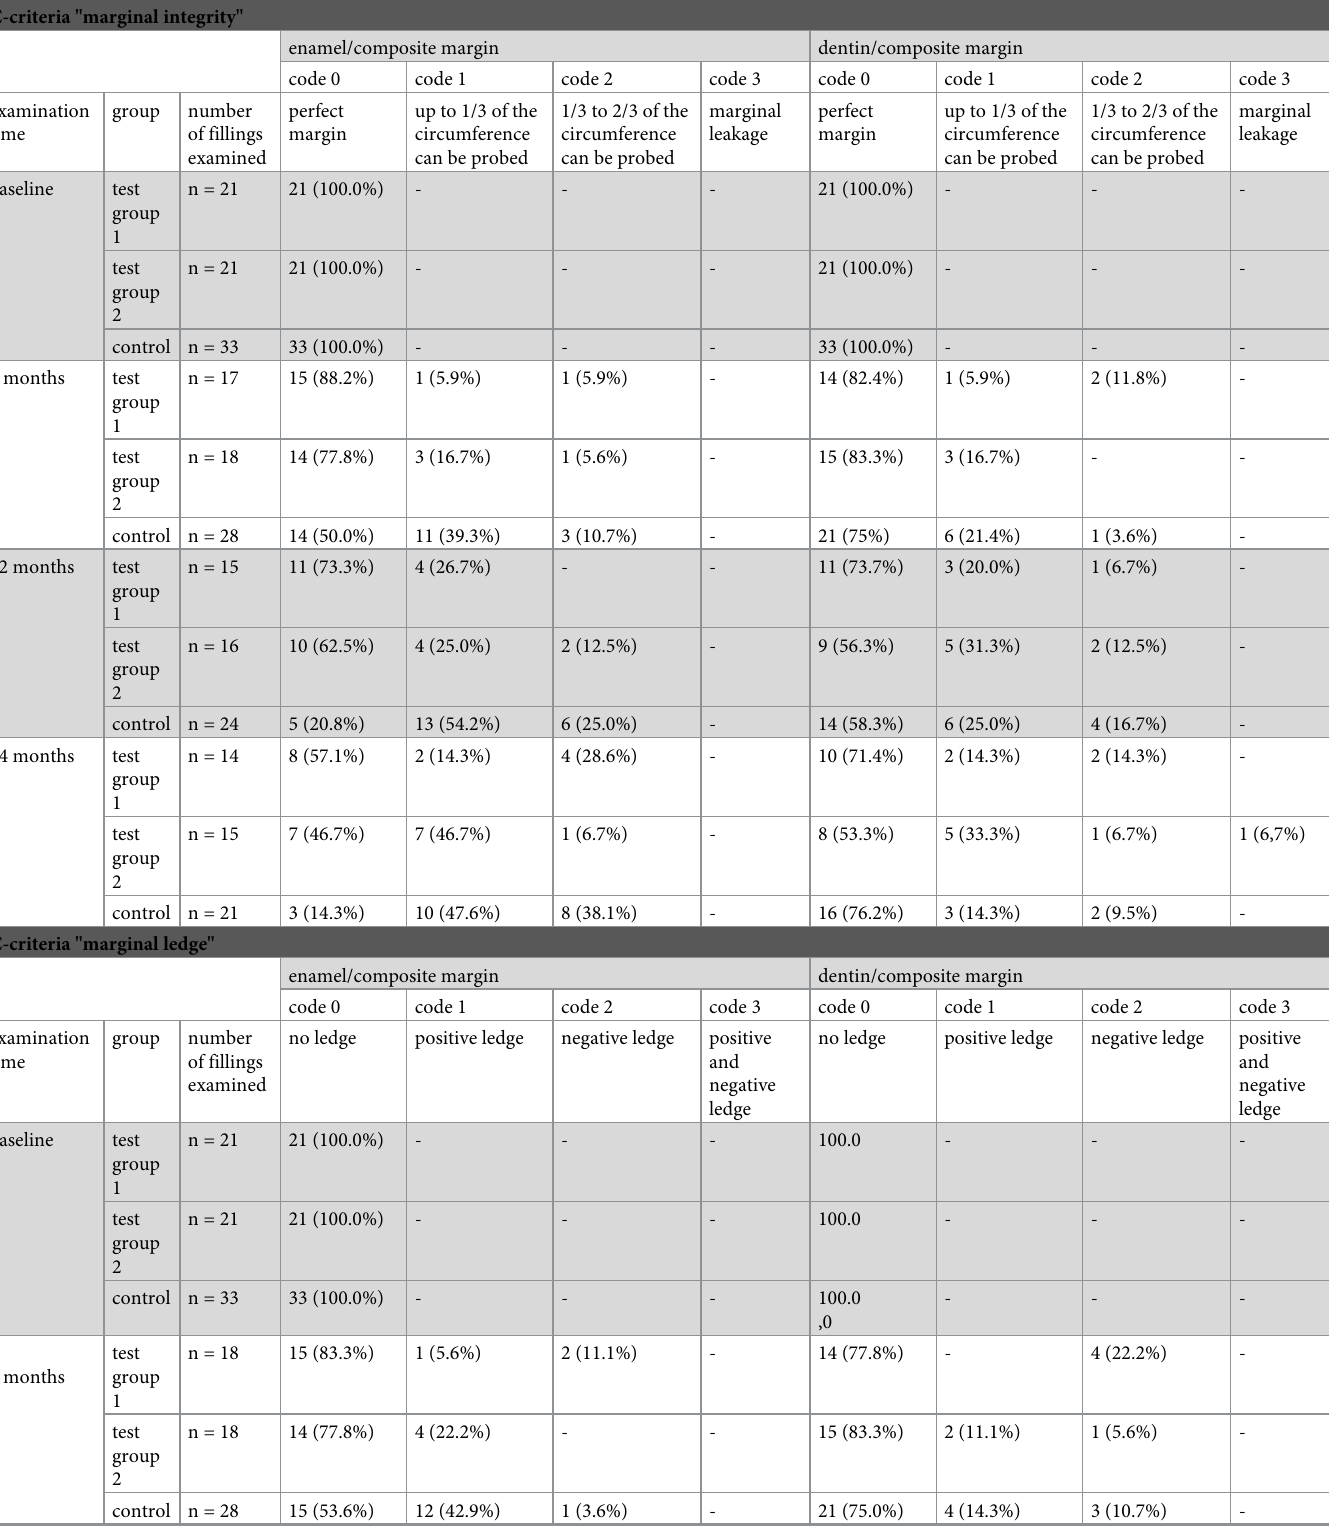
Table 3. Evaluation of Class V restorations according to the C-criteria “marginal integrity”, “marginal ledge”, “marginal discoloration” of the CPM index. C-criteria "marginal